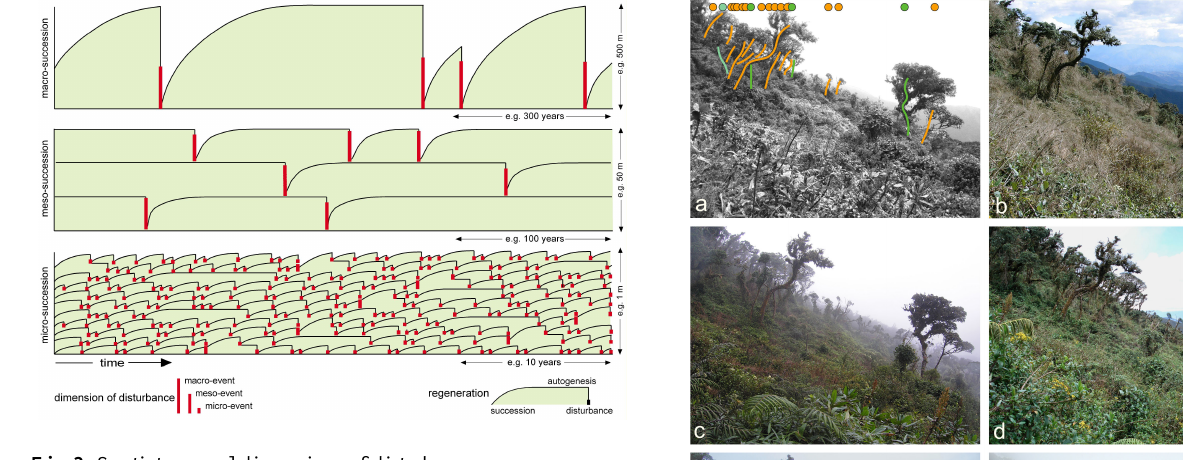
Fig. 3. Spatiotemporal dimensions of disturbances.